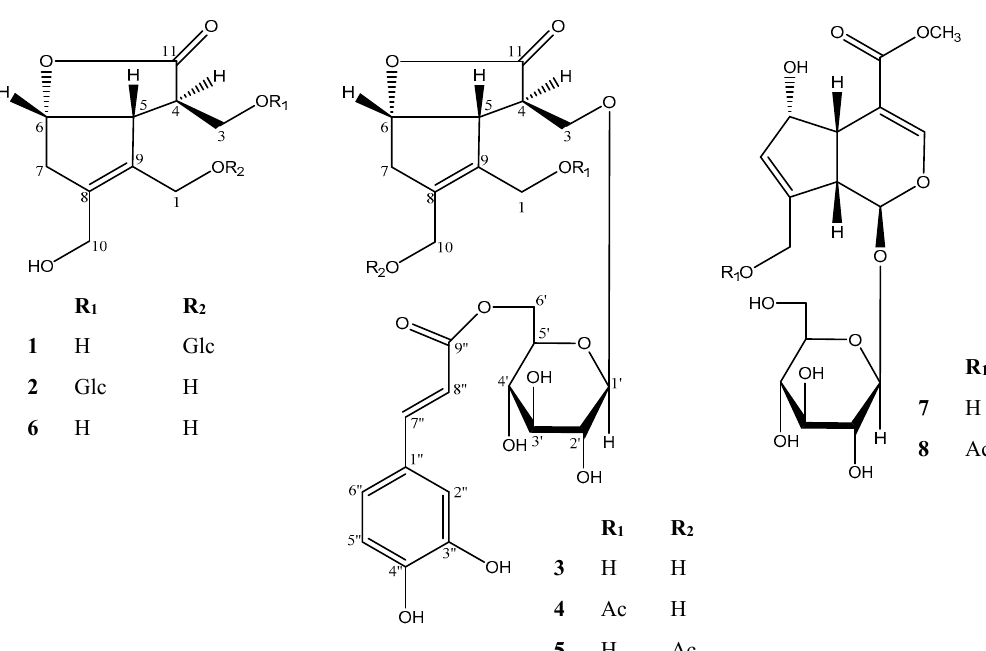
Figure 1. Isolated compounds from Lasianthus verticillatus ( 1 – 8 ).